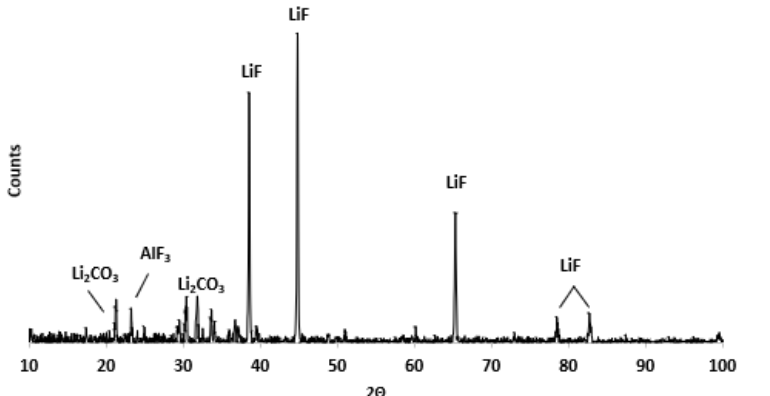
Figure 4. The effect of leaching temperature on Li leaching efficiency: ( a ) pyrolysis and ( b ) incineration (Leaching condition: ( a ). L/S ratio = 20:1 mL g −1 , 80 °C and RT, 300 rpm, and 3 h). RT: room temperature.